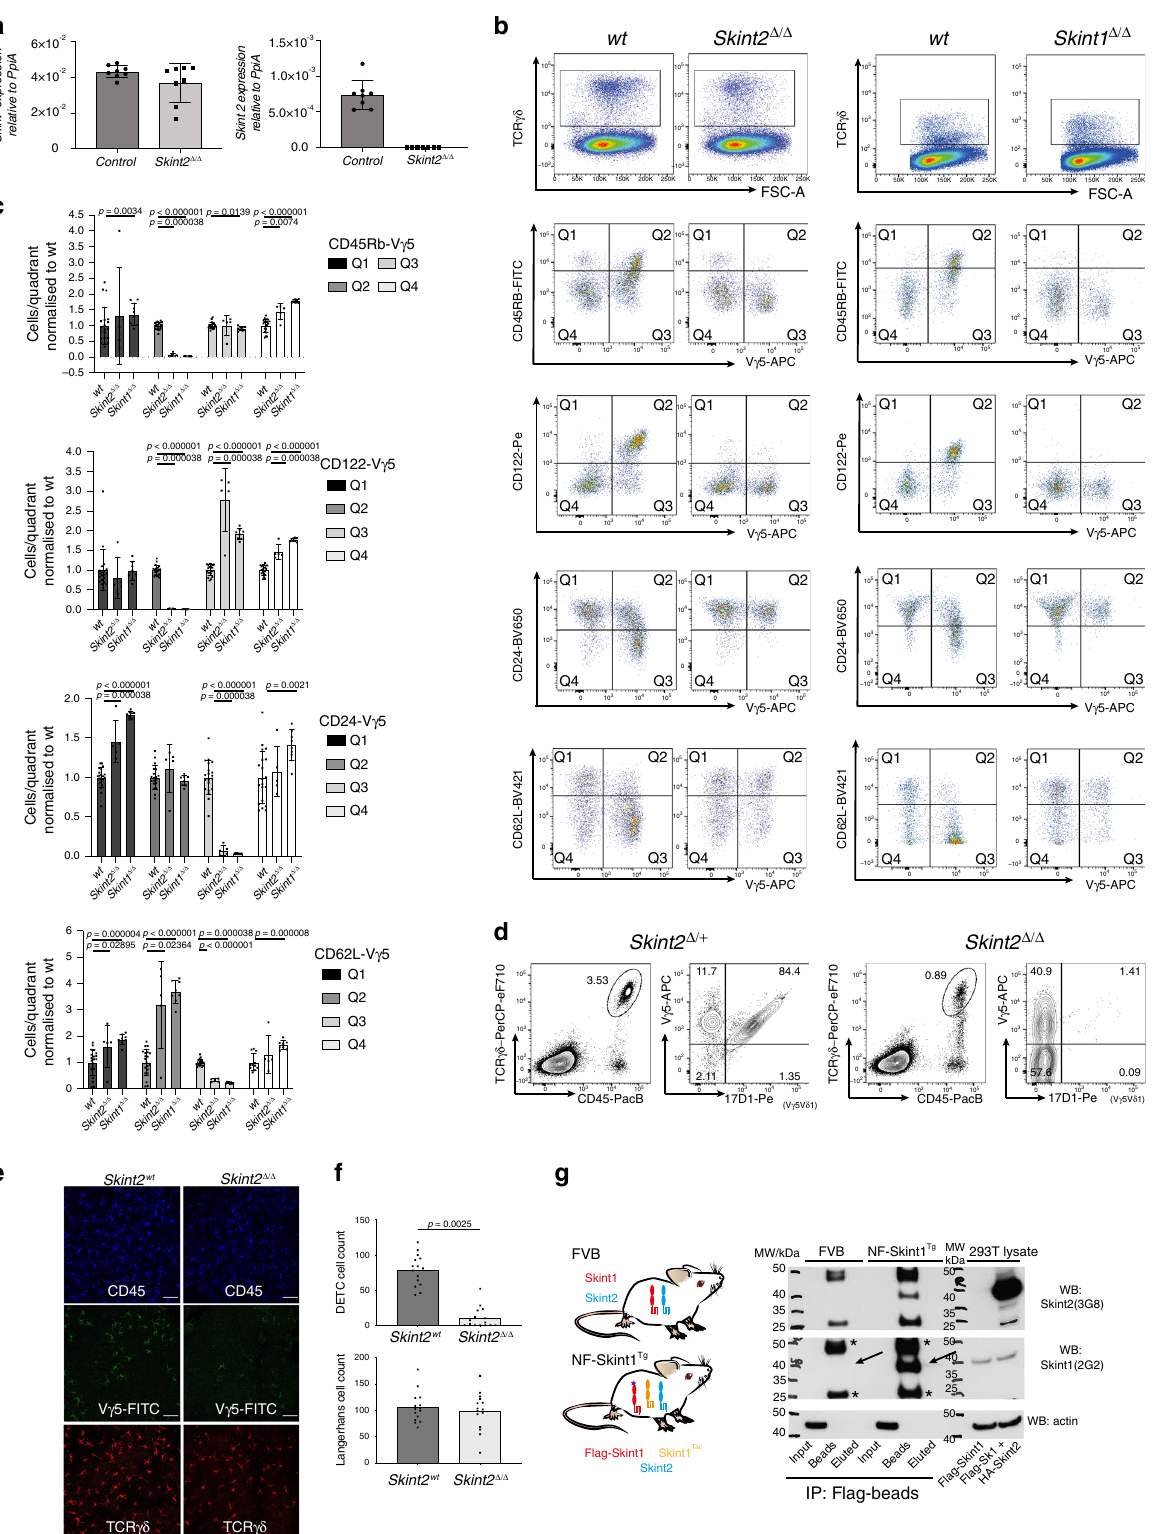
failure to detect Skint1 or Skint2 in total input protein is consistent with their very low levels of protein expression 32 . The inef fi ciency of Skint1/Skint2 elution from the beads seemingly re fl ects a greater af fi nity of the anti-Flag antibody for Flag-tagged Skint proteins versus Flag peptide. This notwithstanding, the data show an evident capacity of Skint1